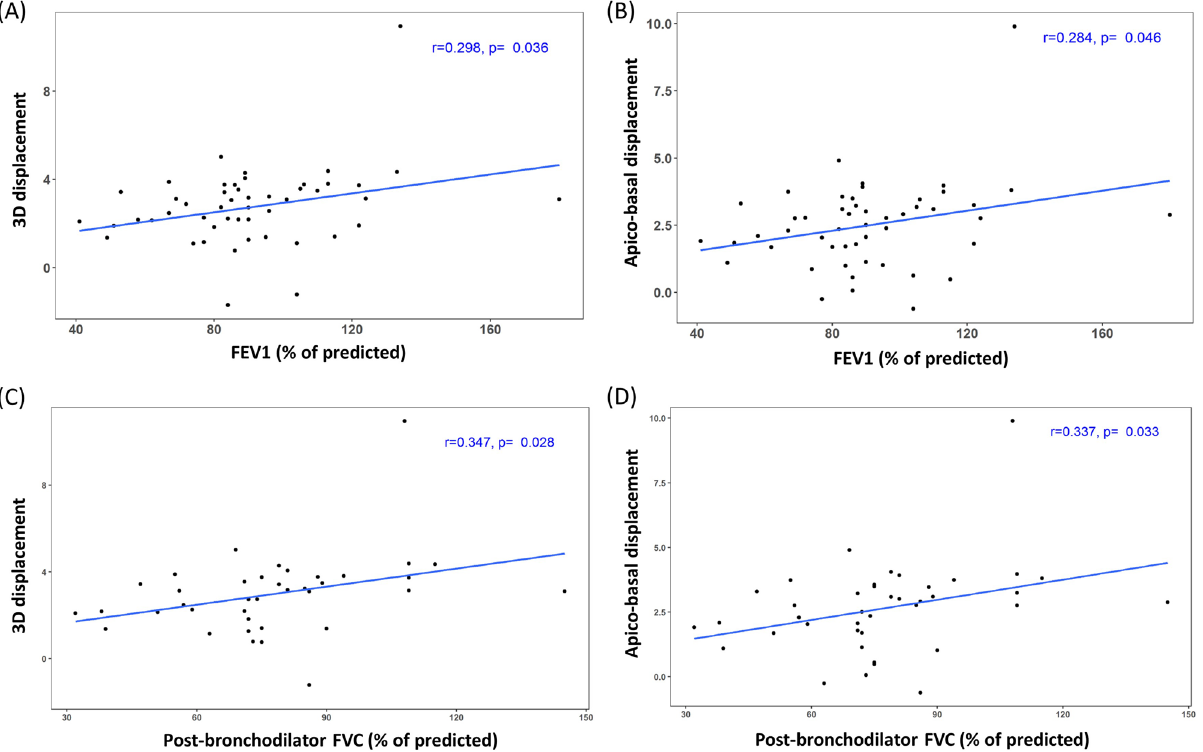
Figure 5. Correlation between pulmonary function test variables and magnitude of displacement vectors in IPF patients. ( A , B ) Correlation between forced expiratory volume in 1 s (FEV1 [% of predicted]) and displacement of the diaphragm. ( A ) FEV1 (% of predicted) is positively correlated with 3D displacement of the diaphragm (r = 0.298, P = 0.036). ( B ) FEV1 (% of predicted) is positively correlated with apico-basal displacement of the diaphragm (r = 0.284, P = 0.046). ( C , D ) Correlation between forced vital capacity after the administration of bronchodilator (Post-bronchodilator FVC) and displacement of the diaphragm. ( C ) Post-bronchodilator FVC (% of predicted) is positively correlated with 3D displacement of the diaphragm (r = 0.347, P = 0.028). ( D ) Post- bronchodilator FVC (% of predicted) is positively correlated with apico-basal displacement of the diaphragm (r = 0.337, P =